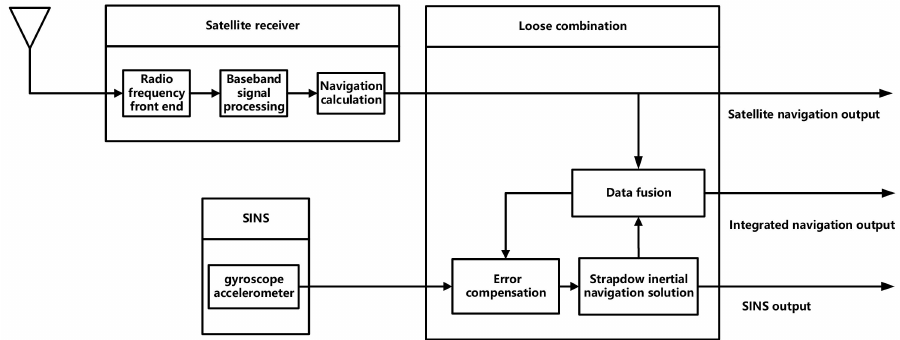
Figure 14. Integrated navigation using a loose combination between satellite and inertial device data.